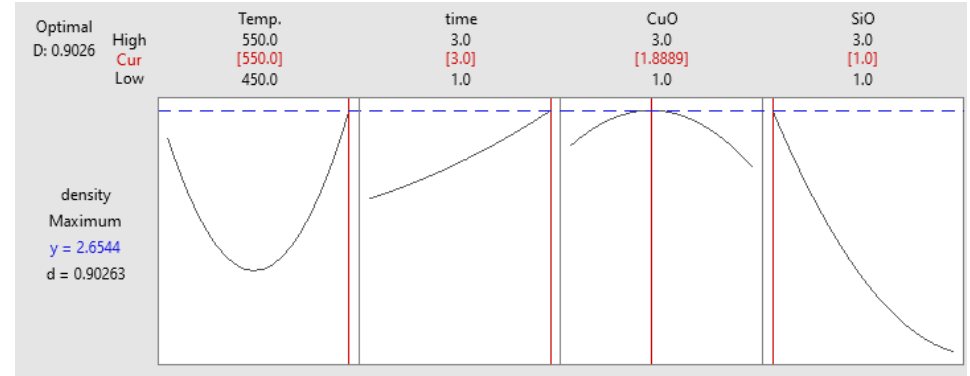
Figure 16. Optimisation plot for